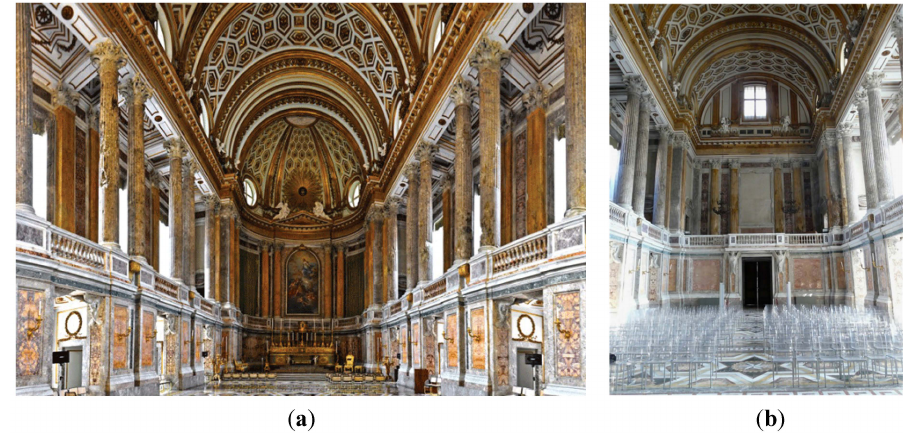
Figure 2. Views of the Palatine Chapel toward the apse ( a ) and toward the royal tribune ( b